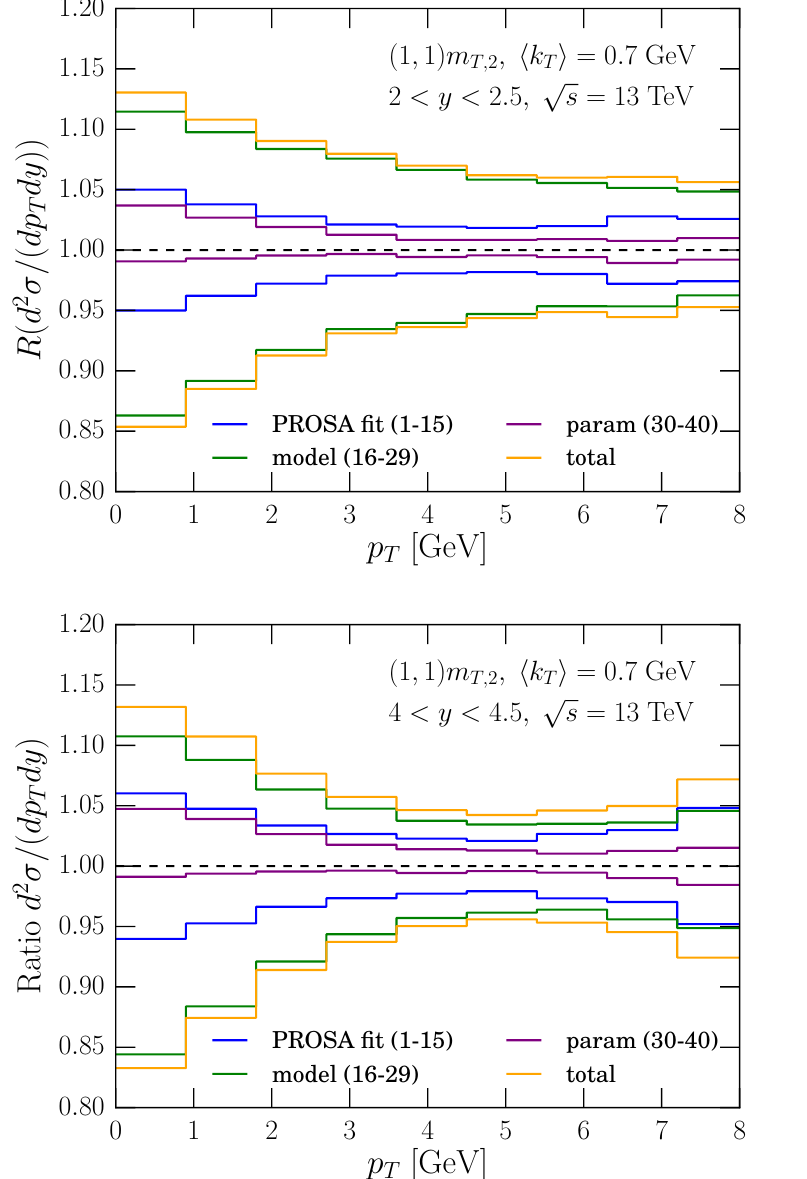
√ + D − production at s = s s rapidity ranges: 2 . 0 < y < 2 . 5 (upper) and 4 . 0 < y < 4 . 5 s